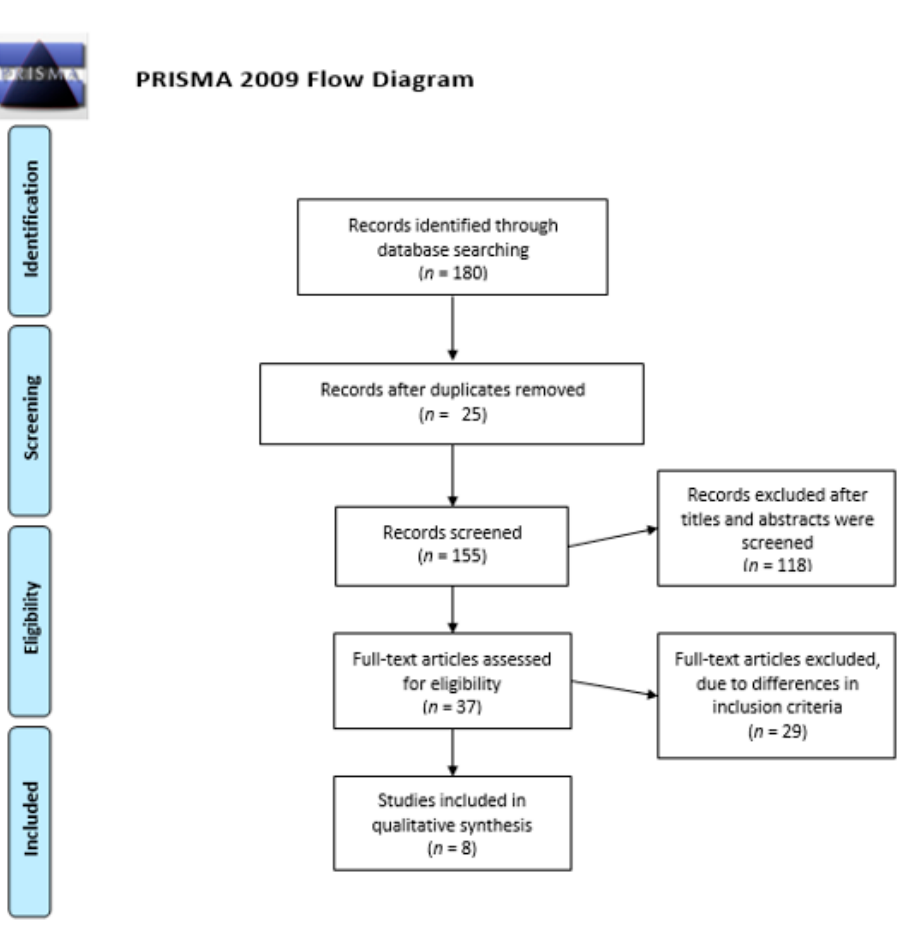
Figure 1. PRISMA flow diagram.